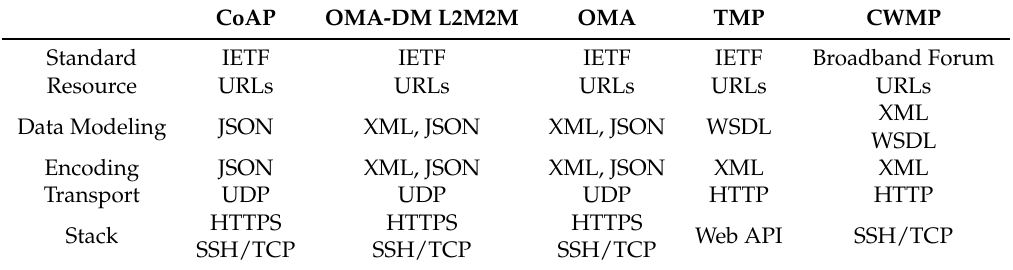
Table 6. Main characteristics comparison of the IoT Device Management protocols.